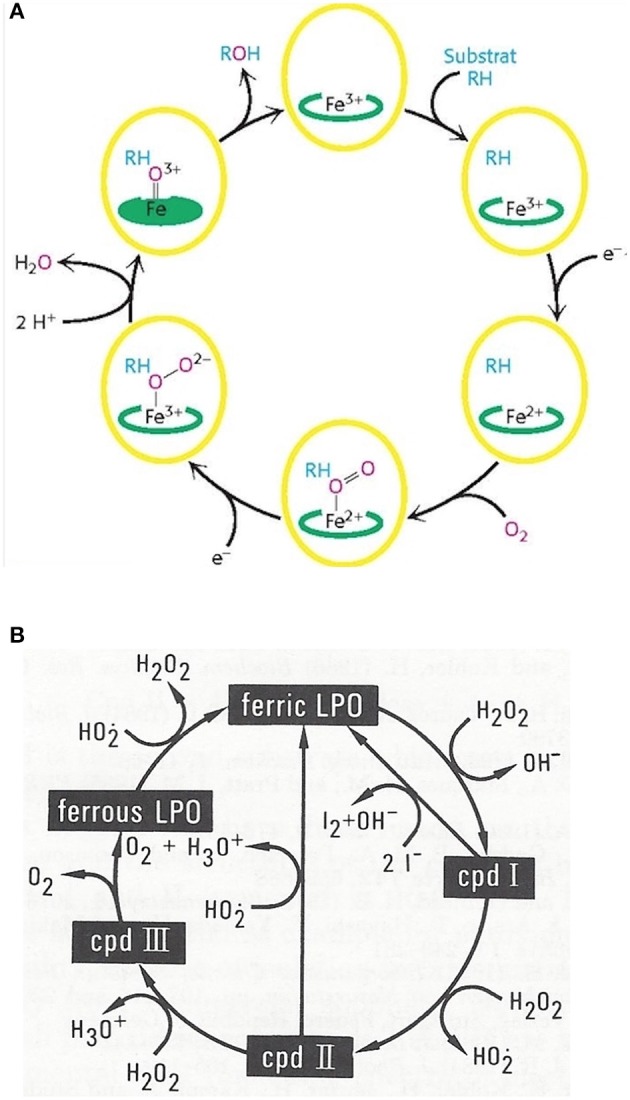
Outline of the catalytic cycles of oxidoreductases. (A) Hydroxylation of substrates of aromatase requires the activation of oxygen. This activation is promoted by the heme prosthetic porphyrin ring system. An electron transfer reduces the ferric to the ferrous intermediate state, which enables iron to bind dioxygen. Another electron transfer induces a rearrangement of the highly electron-dense π-system and cleavage of the O-O bond. One of the oxygens is protonated and liberated as water. The remaining oxygen is configured as ferryl intermediate which extracts a hydrogen atom from the substrate. A transient radical of the substrate thus formed captures the OH group from the enzyme intermediate to end up as hydroxylated substrate. With the permission of Berg et al. (68). (B) Pathways in lactoperoxidase-catalyzed H2O2 metabolism. I− reacts with compound I by direct 2e− transfer. The normal peroxidatic cycle includes ferric lactoperoxidase -> compound I -> compound II -> ferric lactoperoxidase. H2O2 in excess leads to formation of compound III and reconversion to the resting enzyme via the ferrous state. Compound III pathway is combined with irreversible inactivation of the enzyme. The conceivable structures of the heme moieties of lactoperoxidase's ground state and intermediate enzymatic compounds show a movement of iron out of plane (not depicted) (65, 69).